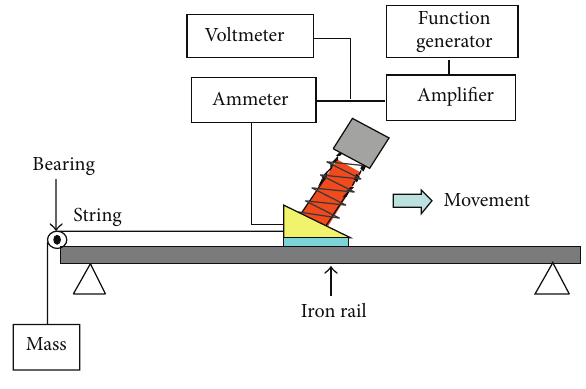
Figure 7: Measurement of pulling force.